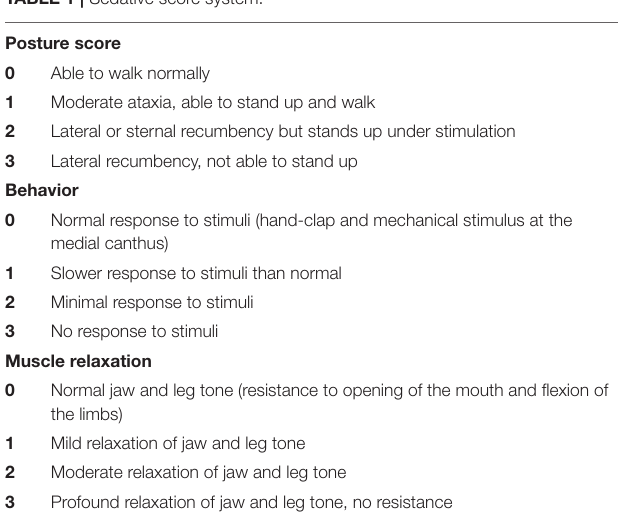
TABLE 1 | Sedative score system.